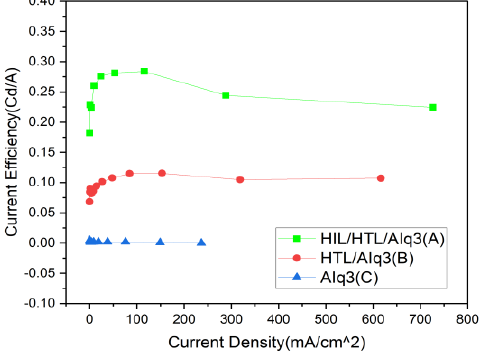
Figure 7. The curves of current efficiency and current density characteristics with linear – linear scale.